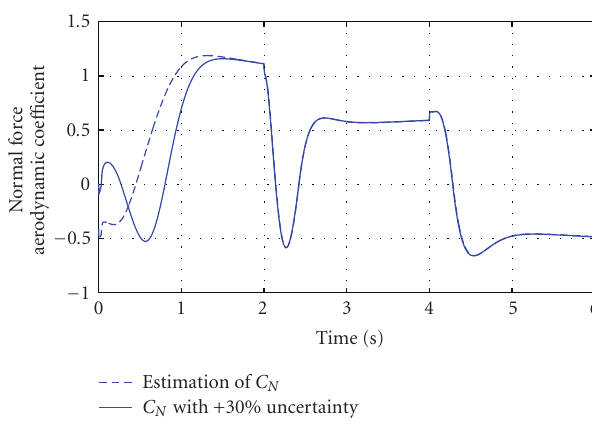
Figure 15: Normal force aerodynamic coe ffi cient estimation with adaptive sliding observer-control.